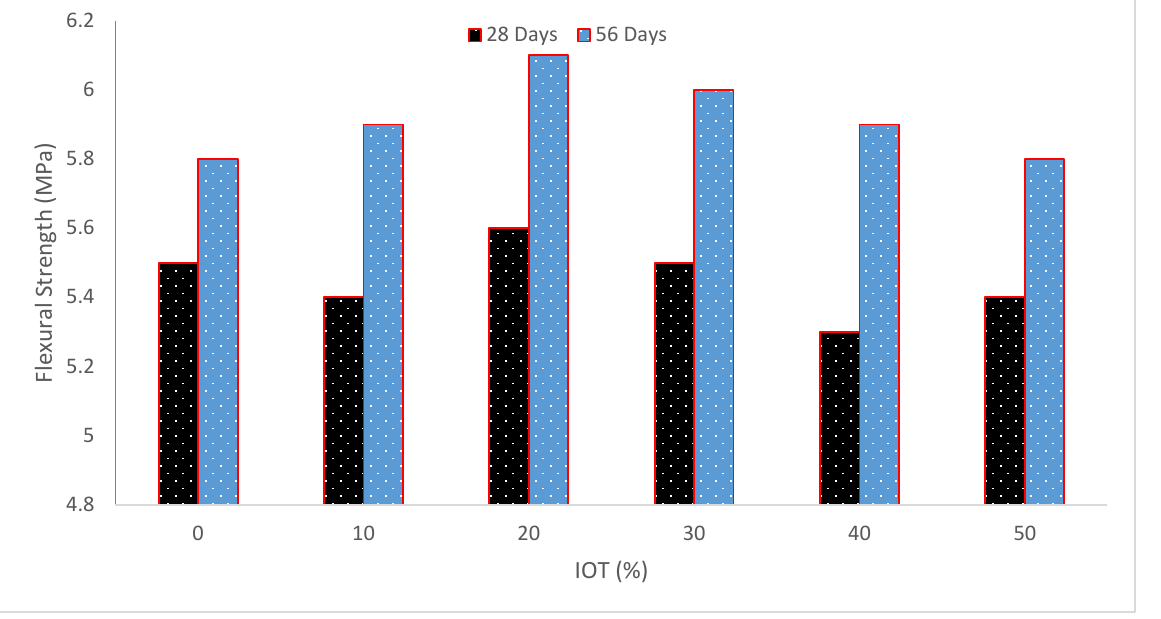
Figure 11. Flexural strength (data source [36]). Table 5. Summary of flexural strength.